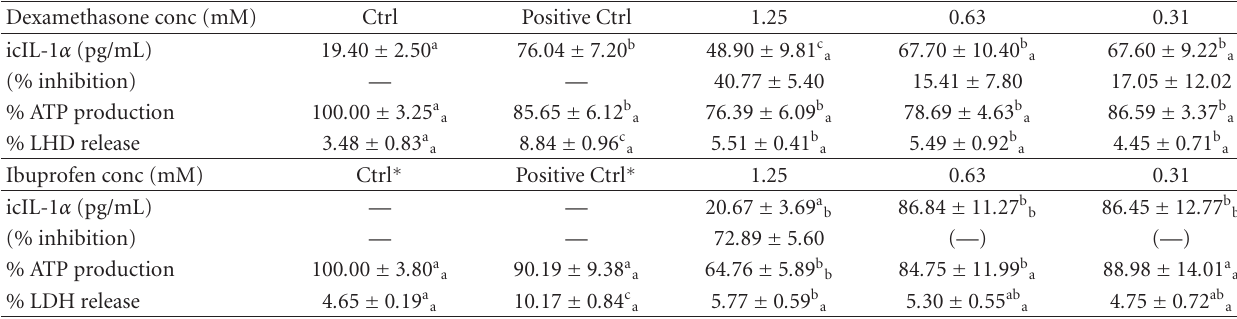
Table 4: E ff ect of dexamethasone and ibuprofen on icIL-1 α production, cell viability and cytotoxicity. Dexamethasone conc